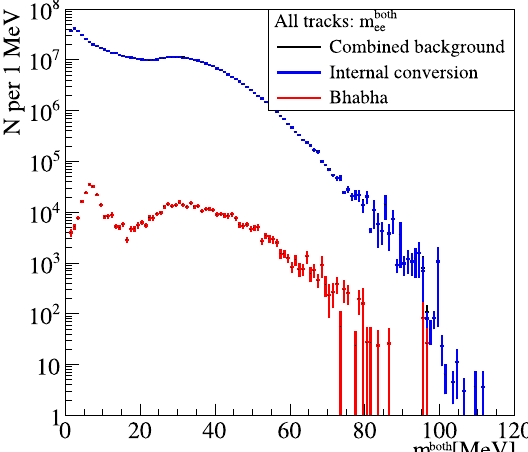
Fig. 42 Spectra of the reconstructed invariant mass m ee of both e + e − combinations for signal prompt dark photons decays and background from rare muon decays and accidental combinations. The signal spectra are drawn normalized to one. For the background spectra, 300 days of data taking at 10 8 µ / s as expected in phase I of Mu3e are